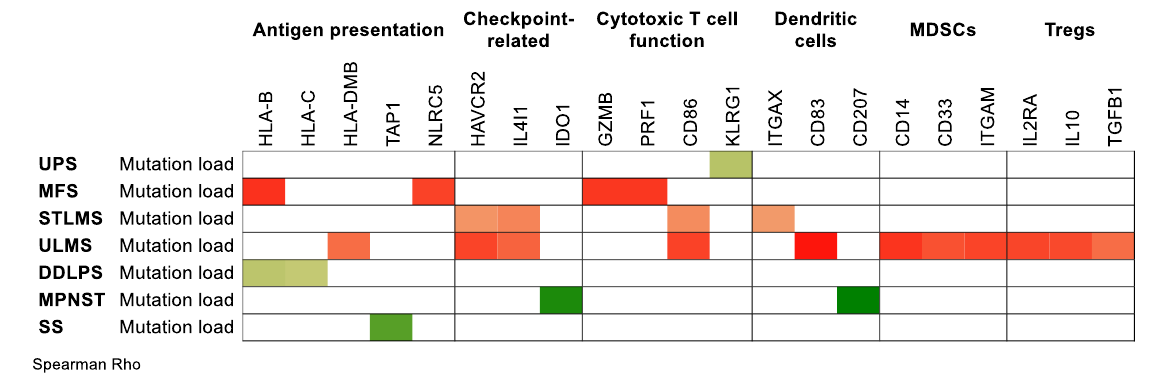
Figure 2. Increased mutation load is associated with the expression of select immune-related genes in soft tissue sarcomas. Red represents positive while green represents negative Spearman Rho correlation coefficients. Only p < 0.05 associations are shown. Orange arrows indicate subtypes that responded to immunotherapy in SARC028.